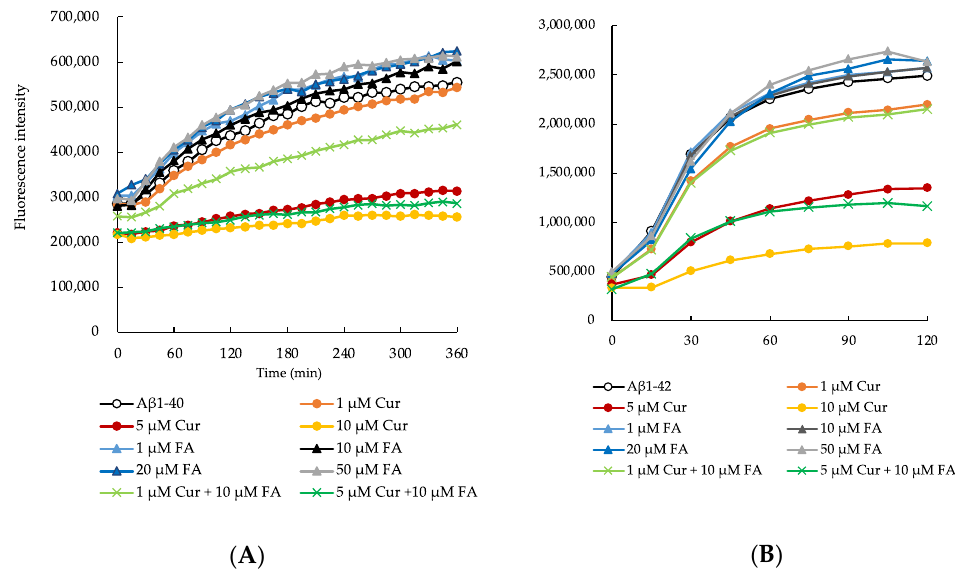
Figure 2. The aggregation kinetics of Aβ 1 – 40 ( A ) and Aβ 1 – 42 ( B ) with Cur, FA, or Cur + FA as measured with the ThT assay.